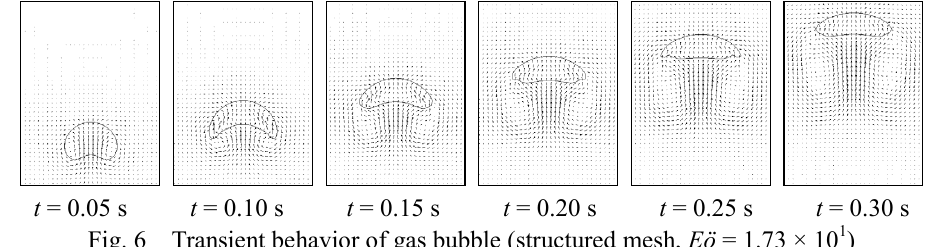
Transient behavior of gas bubble (structured mesh, Eö = 1.73 × 10 1 )